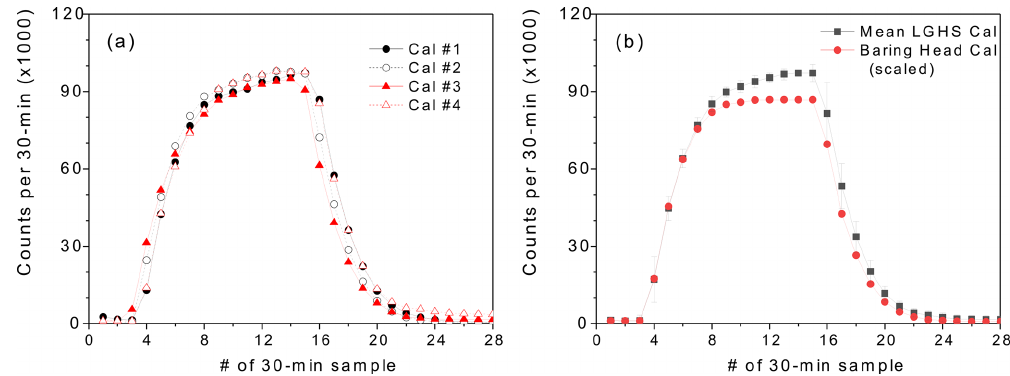
Figure 12. (a) Summary of 4 calibration events for the 1500L radon monitor, and (b) comparison of the mean LGHS calibration event with a scaled calibration event of matching duration for a 1500L radon detector operating at a coastal site in New Zealand.